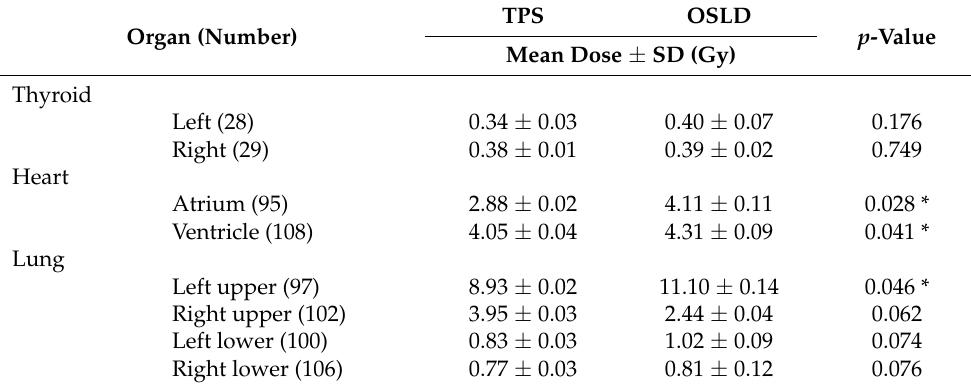
Table 5. Comparison of the TPS calculated doses and the doses measured by OSLDs of the VMAT